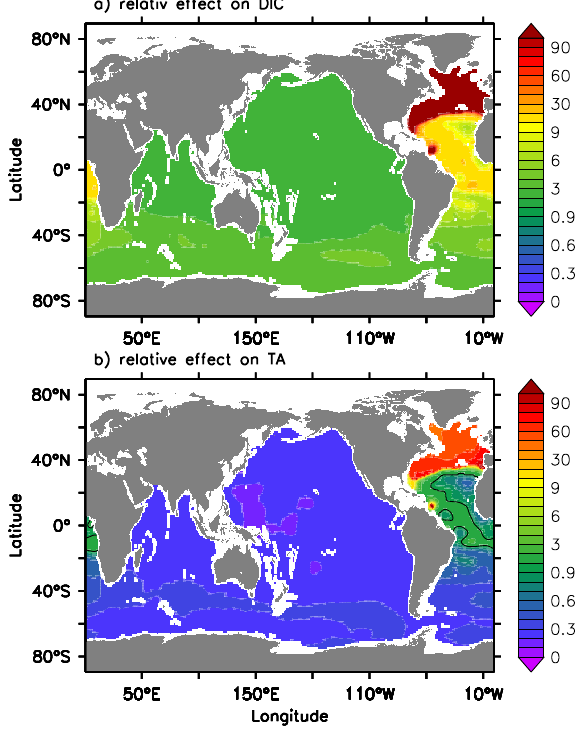
Figure 1. Ratio of the imprint of the organic tissue pump and the CaCO 3 pump on TCO 2 (a) and TA (b) at 2000m water depth. 1 DIC tissue and 1 TA tissue are computed from estimates of the apparent oxygen utilization (AOU) and the mean molar oxy- gen:carbon ratio of 1.4 and the mean molar oxygen:alkalinity ratio of 0.119 ( = 1 / 170 × 16 × 1 . 26), respectively. AOU is esti- mated using oxygen, potential temperature and salinity data from the World Ocean Atlas (gridded data, analysed annual means). 1 TA CaCO 3 is computed using the TA ∗ method described in Sect. 3 applied to the GLODAP gridded data set (Key et al., 2004). 1 DIC CaCO 3 = 0.5 × TA ∗ .